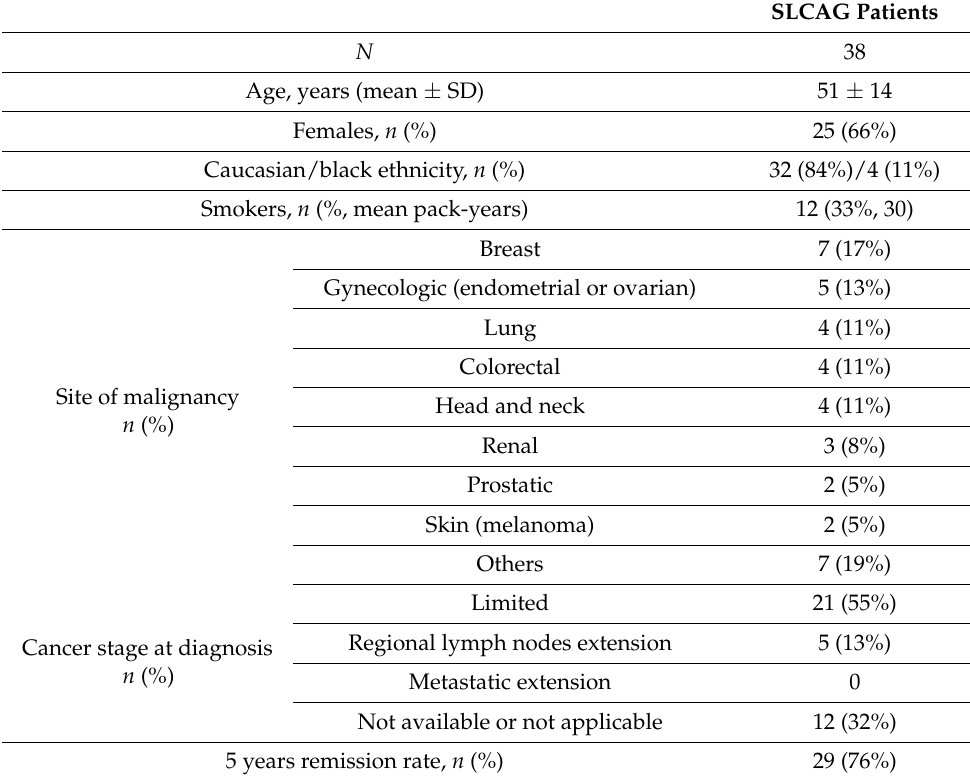
Table 1. Demographics and malignancy characteristics of SLCAG patients.